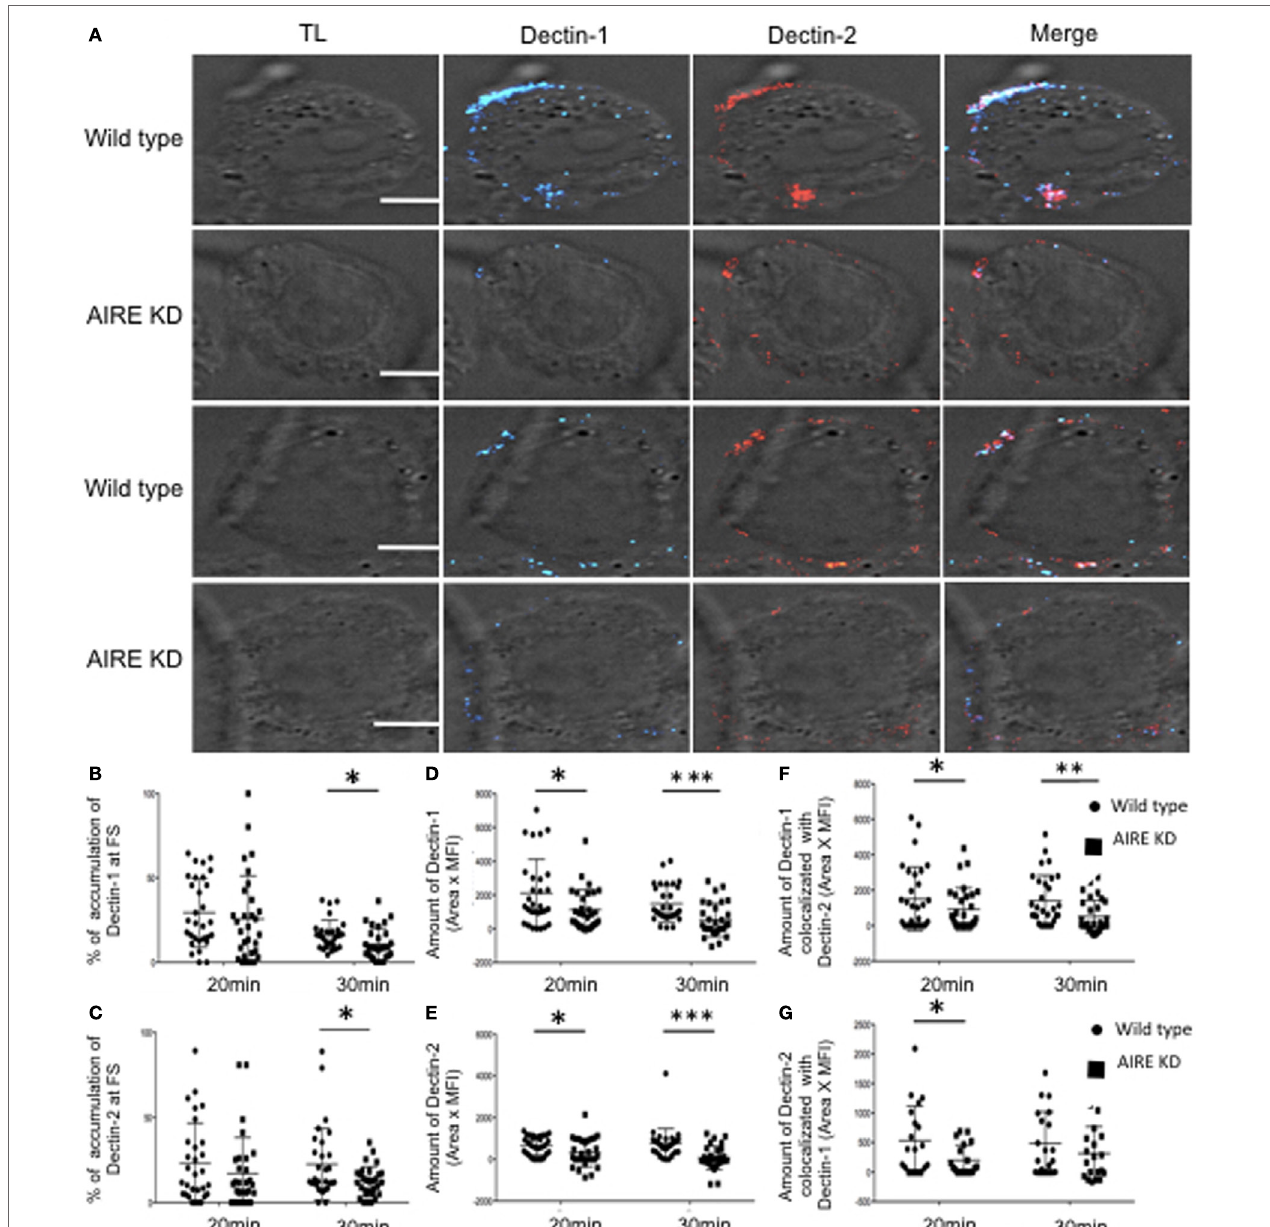
FigUre 3 | AIRE-mediated recruitment of Dectin receptors to fungal synapse (FS). (a) Representative confocal micrographs of wild-type and AIRE-knockdown macrophage-like THP-1 cells stimulated with C. albicans hyphae for 20 or 30 min to observe the recruitment of Dectin-1 (blue) and Dectin-2 (red) receptors to the FS. (B–e) Each dot represents a cell used for the measurement indicated. The horizontal bars denote the mean. * p < 0.05 as determined by the t -test. (B,c) Percentages of total Dectin-1 (B) and Dectin-2 (c) at the FS compared with that in the whole cell. (D,e) Amounts of Dectin-1 (D) and Dectin-2 (e) at the FS (conjugated-unconjugated cells). (F,g) Synaptic co-localization of Dectin-1 with Dectin-2 (F) or Dectin-2 with Dectin-1 (g) . Representative confocal micrographs of 30 cells counted in 3 independent experiments. Scale bar = 5